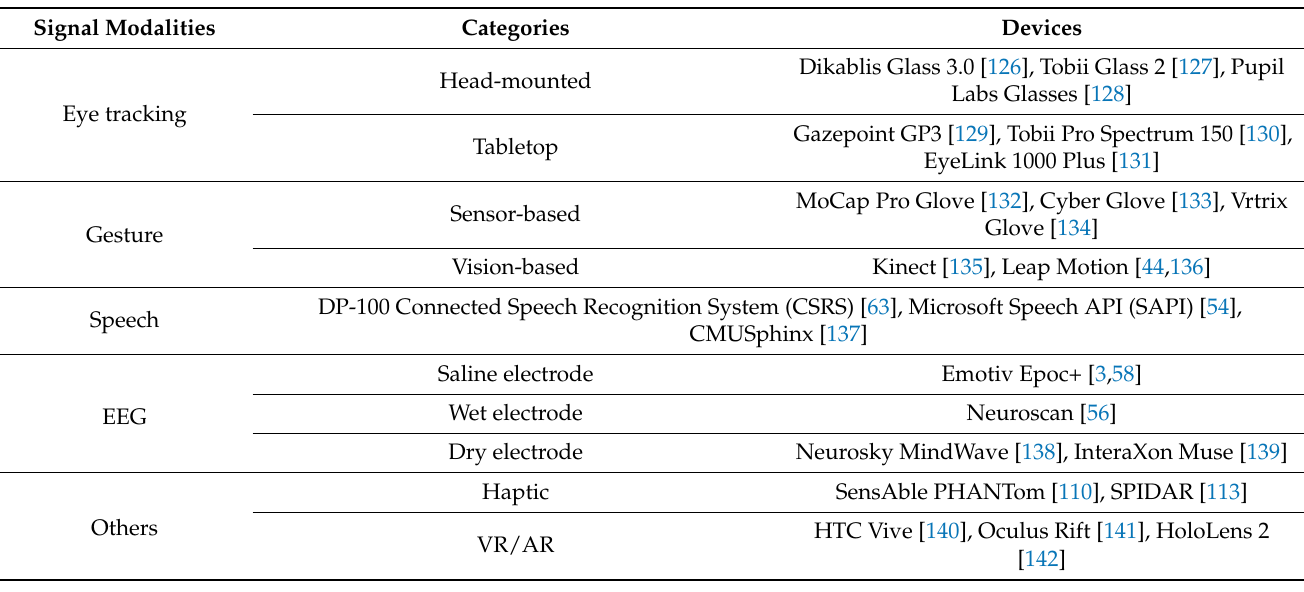
Table 2. Overview of devices for natural